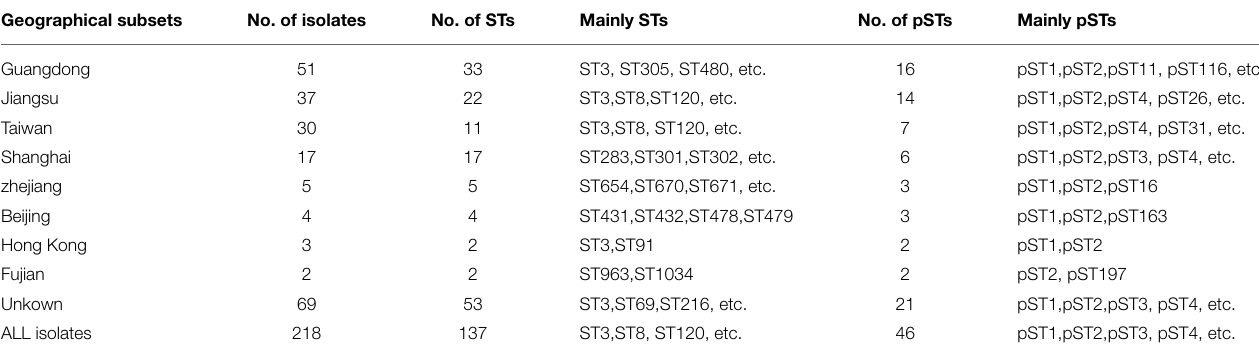
TABLE 2 | Geographic distribution of the 218 V. parahaemolyticus isolates. Geographical